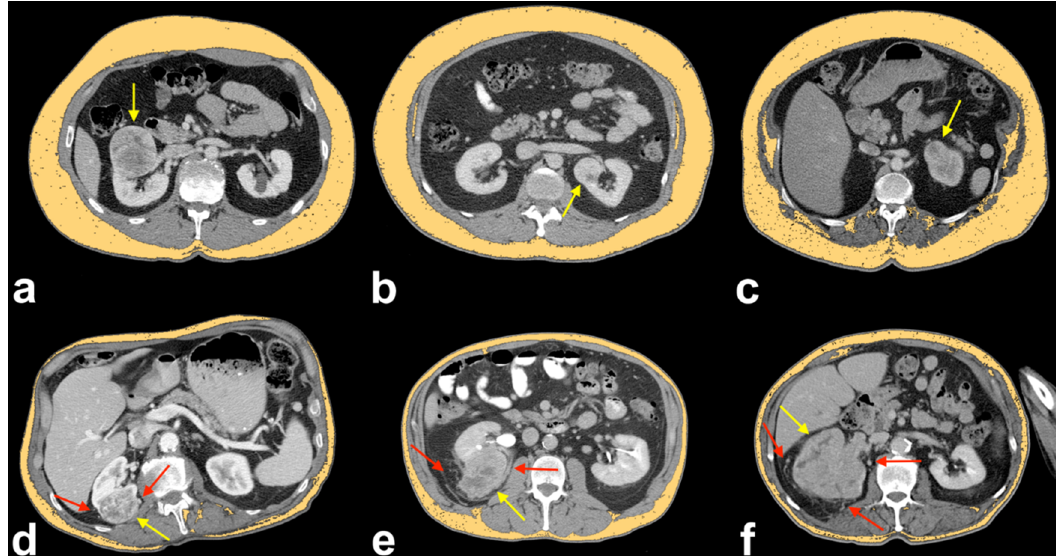
Figure 4. Axial CT images showing the orange ROIs of SAT areas in ccRCCa patients ( a , b and c ) and ccRCCp patients ( d , e and f ), the tumors in ccRCCa patients (yellow arrows in a , b and c ) and ccRCCp patients (yellow arrows in d , e and f ) and peritumoral collateral vessels in ccRCCp patients (red arrows in d , e and f ). Note that there is a clear reduction of SAT in ccRCCp patients ( d , e and f ).